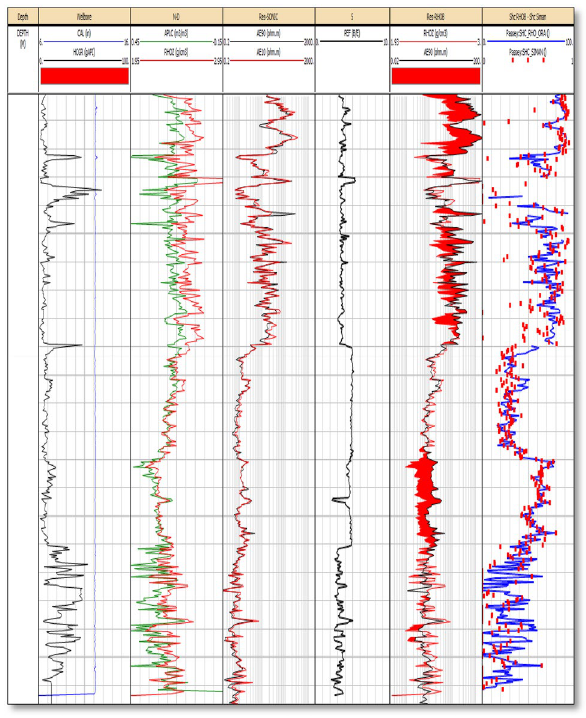
Fig. 35 Field application—carbonate